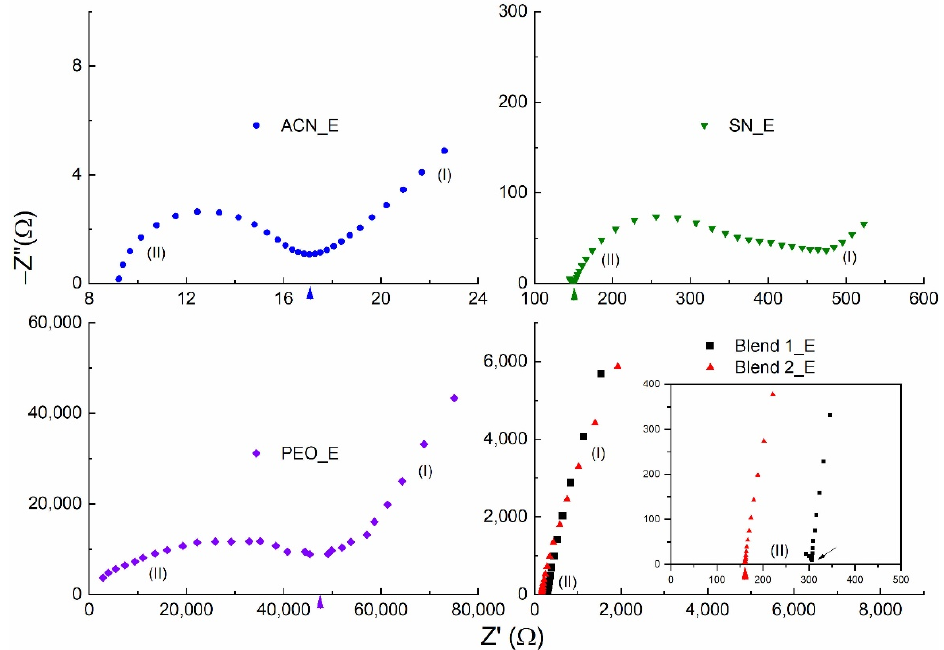
Figure 2. Nyquist curves of the solid (SN_E, PEO_E, Blend 1_E, and Blend 2_E) and liquid (ACN_E) redox mediators at 25 °C. (i) and (ii) represent low- and high-frequency domains, respectively. The inset shows the high-frequency domain of the Blends 1_E and 2_E.